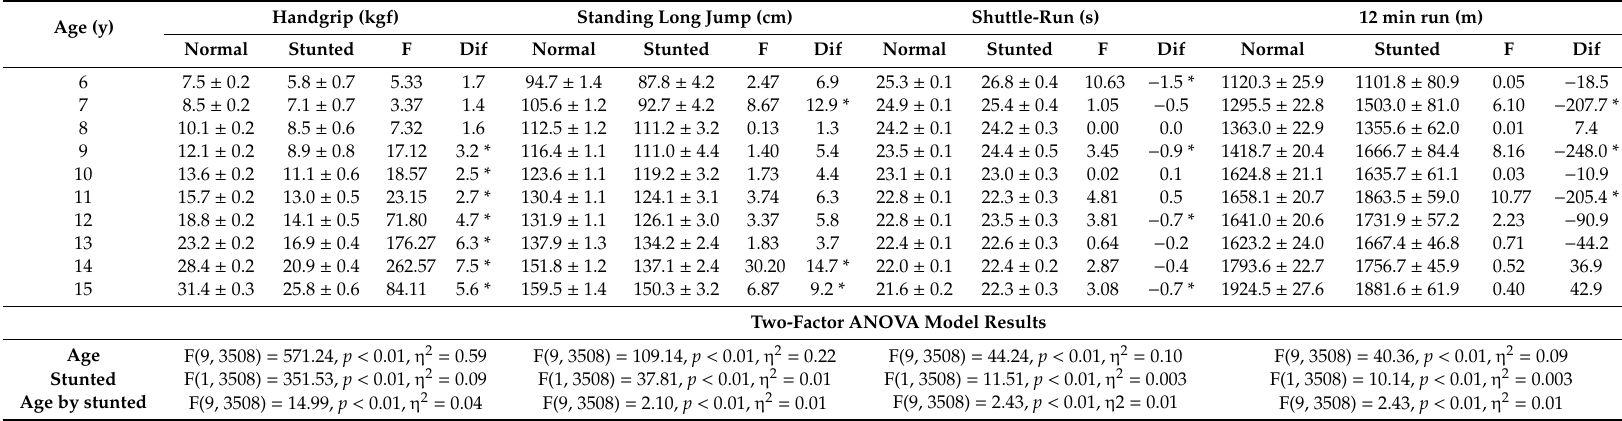
Table 4. Mean di ff erences (Mean ± SD, F tests and Dif) and two-factor ANOVA model results for each physical fitness test between stunted and normal-growth